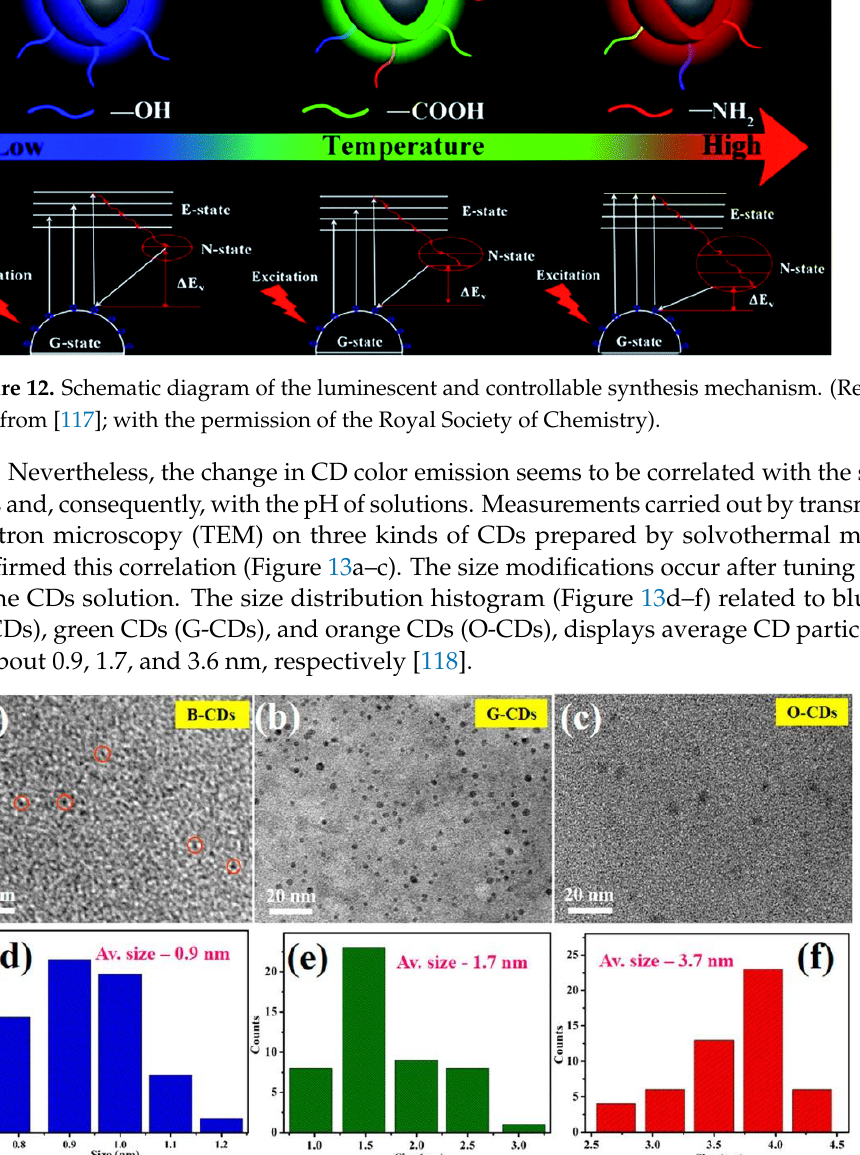
Figure 11. Illustration showing the energy states with different color emission by ( a ) m – CDs and ( b ) o-CDs. (Reprinted from [116]; with the permission of John Wiley and Sons).